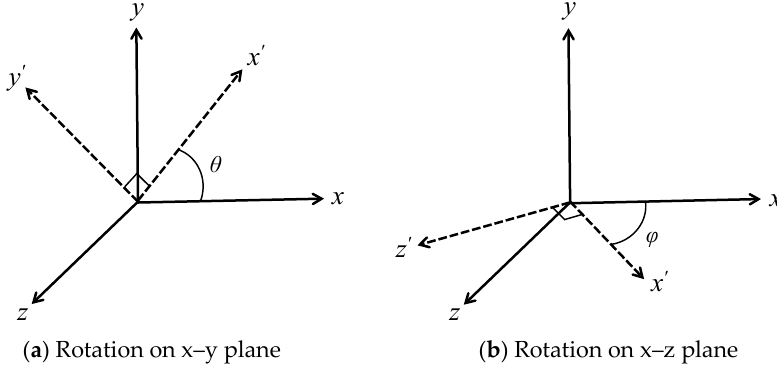
Figure 3. Transformation of Cartesian coordinates.